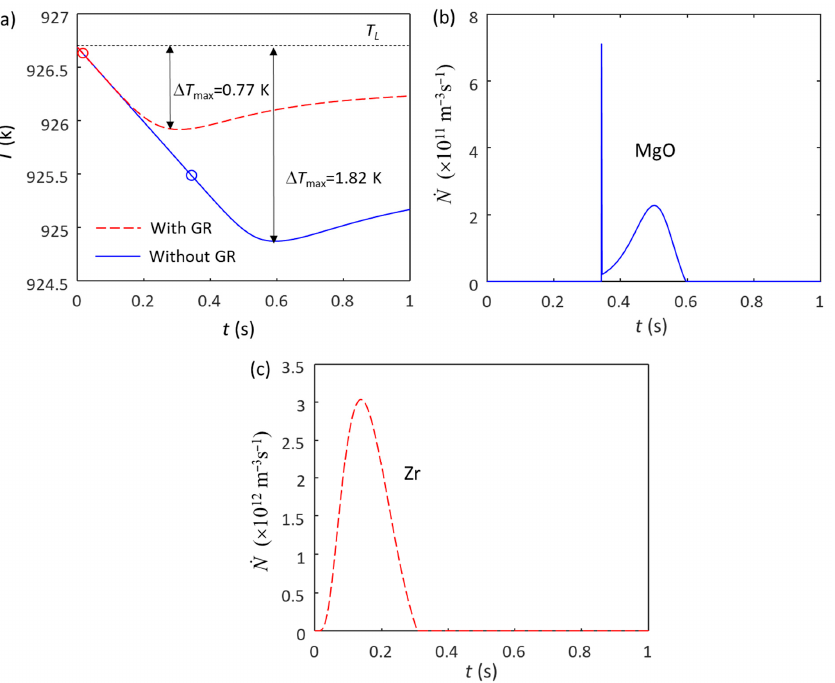
Figure 2. Solidification behavior of Mg-0.45Zr alloy without and with the addition of Mg-Zr grain refiner ( N 0 (Zr) = 10 12 m − 3 ) under a cooling rate of 3.5 K/s. ( a ) Cooling curves; ( b ) grain initiation rate without the addition of Mg-Zr grain refiner; ( c ) grain initiation rate with the addition of Mg-Zr grain refiner. The red and blue dots in ( a ) mark the onset of grain initiation on solid particles induced by Zr and MgO particles, respectively.